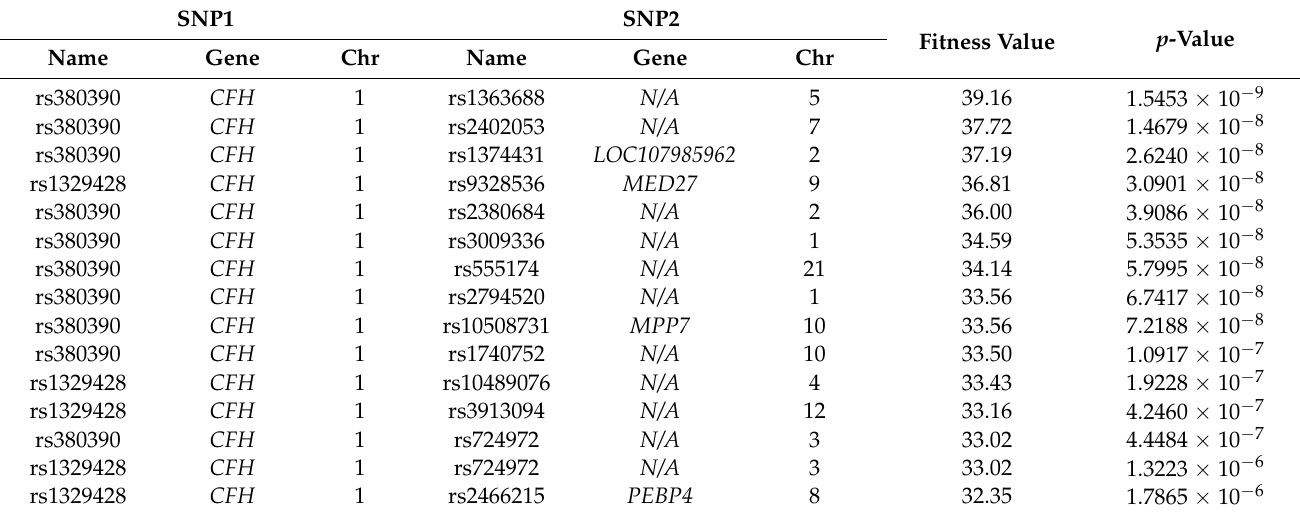
Table 2. Top 15 Captured Epistatic Interactions Associated with